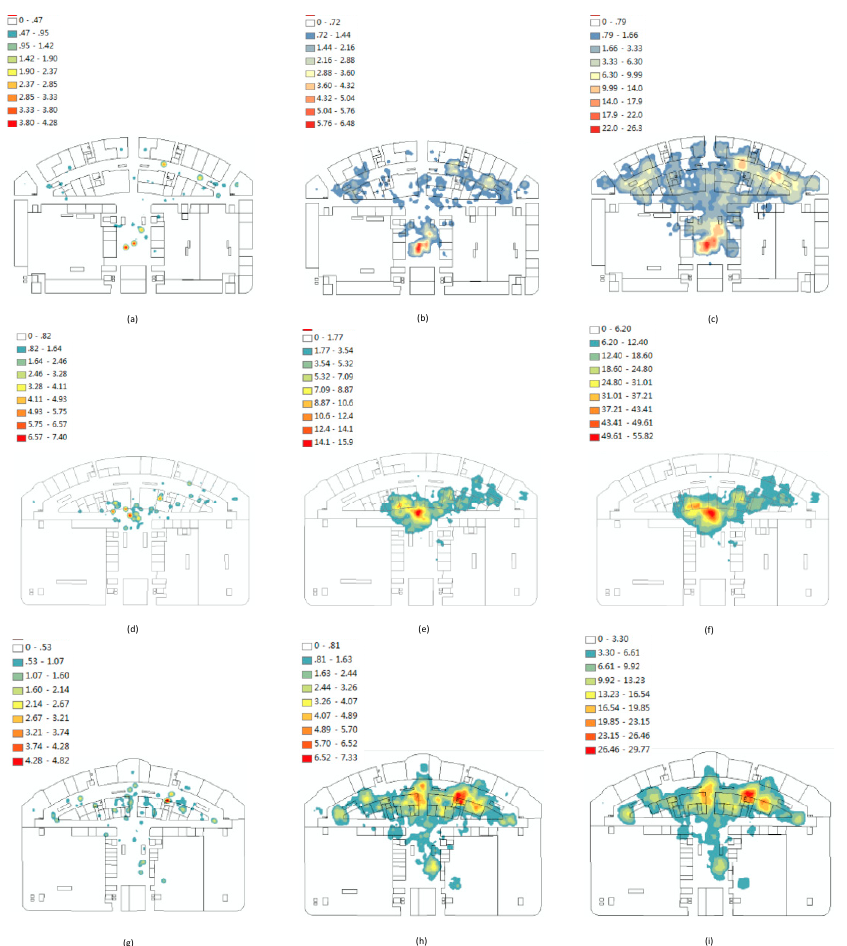
Figure 12. Results of the kernel density analysis of the indoor Wi-Fi position data.